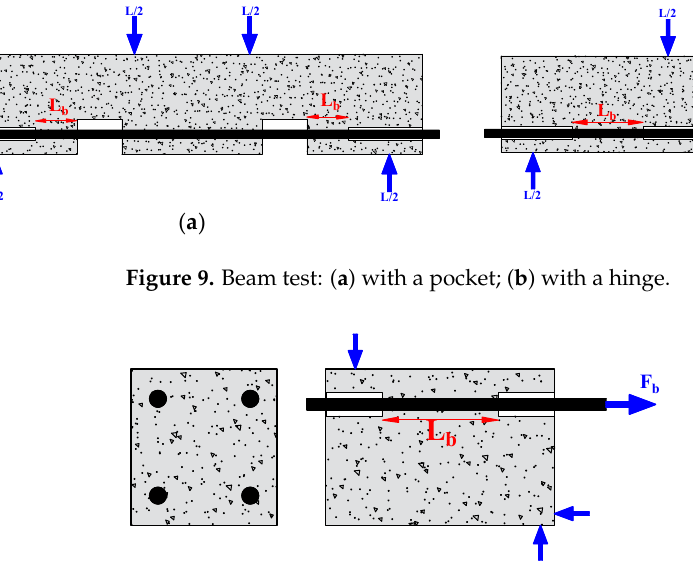
Figure 10. Beam end test proposed by Chana [28].